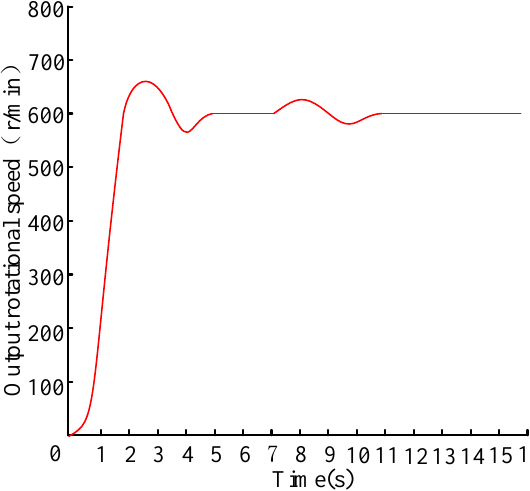
Figure 22. PMSC speed response for the PID algorithm.